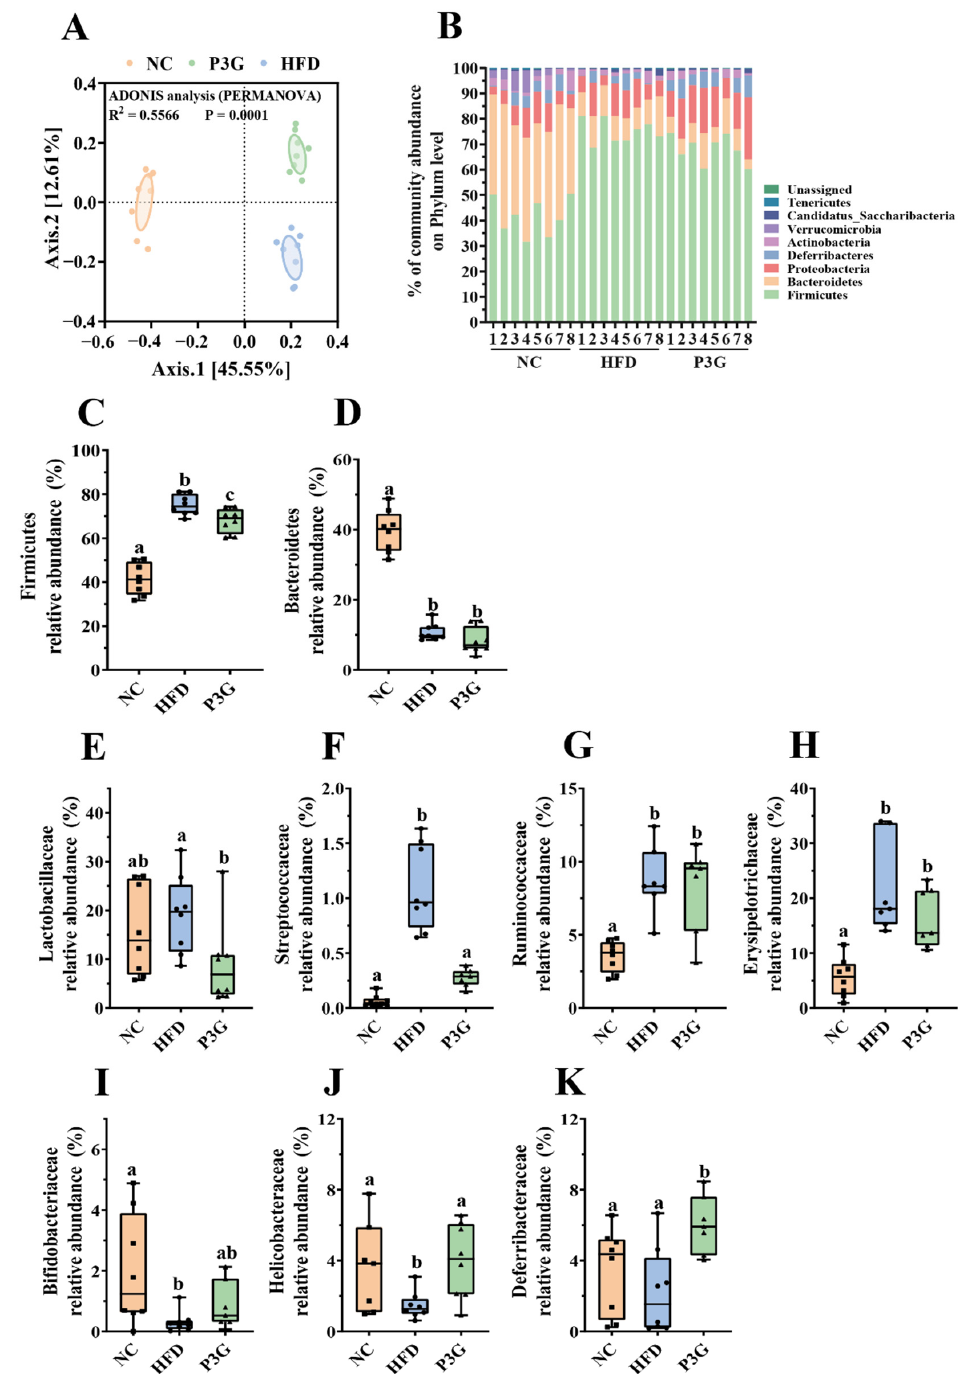
Figure 4. P3G supplementation regulated gut microbial community. ( A ) PCoA of gut microbiota based on the ASV data of the NC, HFD, and P3G groups. ( B ) Bacterial taxonomic profiling at the phylum level of intestinal bacteria from different groups. ( C , D ) The relative abundance of Firmicutes and Bacteroidetes. ( E – H ) Four groups of bacterial families with significantly reduced relative abundance in the P3G group compared to the HFD group. ( I – K ) Three groups of bacterial families with significantly increased relative abundance in the P3G group compared to the HFD group. Box-and-whisker plots are used to represent the data, and one-way analysis of variance (ANOVA) was used to evaluate the data; a, b, and c represent significant differences between groups. The same letter indicates no significance between the two groups, and different letters indicate significance ( p <